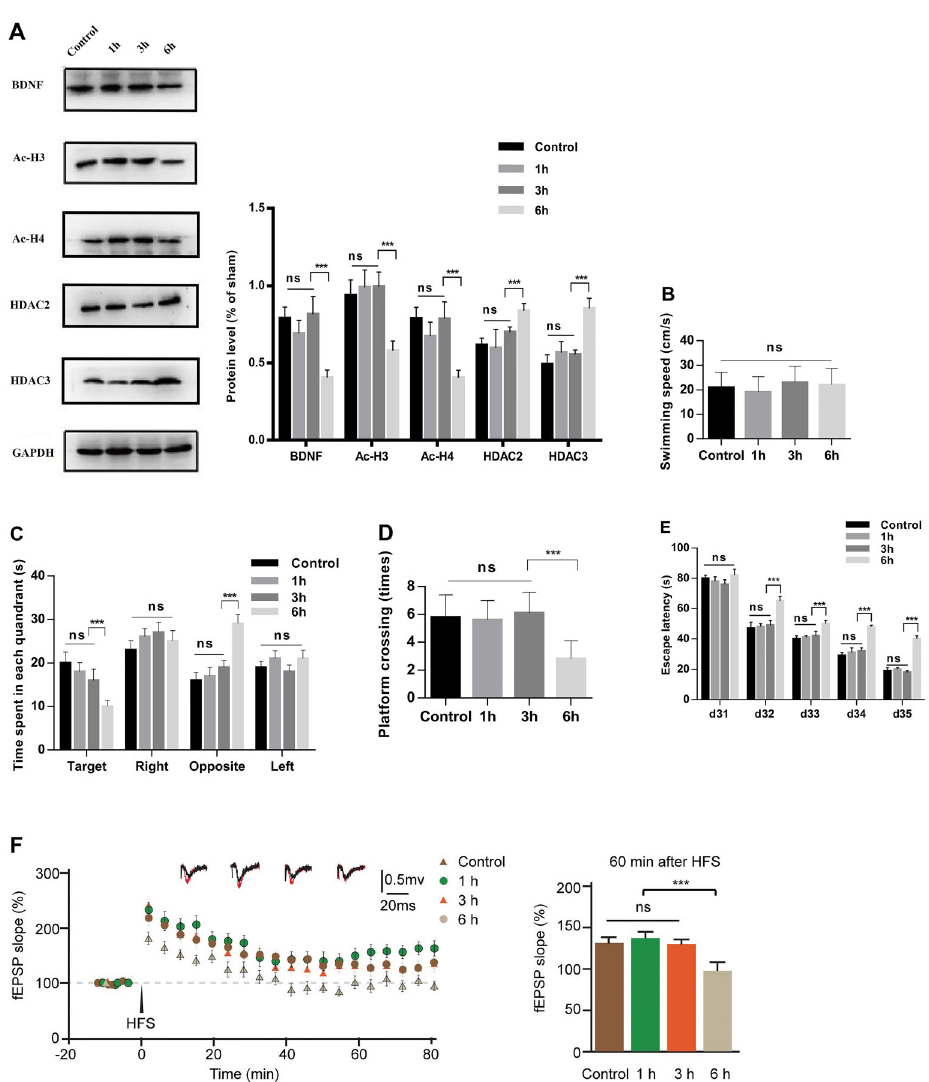
Figure 3. Effects of 2.5% sevo fl urane exposure during late pregnancy on postnatal day 35 offspring rats. A , Exposure to 2.5% sevo fl urane in late-pregnancy rats decreased BDNF, Ac-H3, and Ac-H4 and increased HDAC2 and HDAC3 in the hippocampus of offspring in the 6-h group. B , There were no signi fi cant differences in swimming speed. C , In the 6-h group, the time spent in the target quadrant was decreased and the time in the opposite quadrant was increased. D , Platform crossing times were decreased and E , escape latency was extended. F , Long-term potentiation measured in fi eld evoked postsynaptic potentials (fEPSP) was inhibited after high frequency stimulation (HFS). Data are reported as means ± SD. ***P o 0.001 (ANOVA followed by Tukey ’ s test). ns: not signi fi cant, d: day: EE: enriched environment; SE: standard